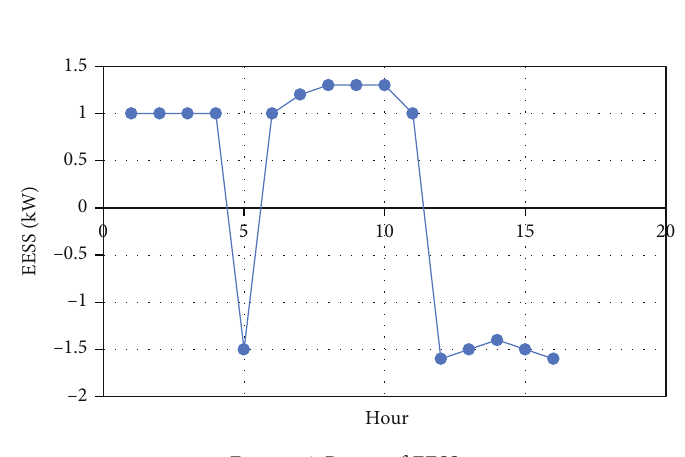
Figure 6: Power of EESS.